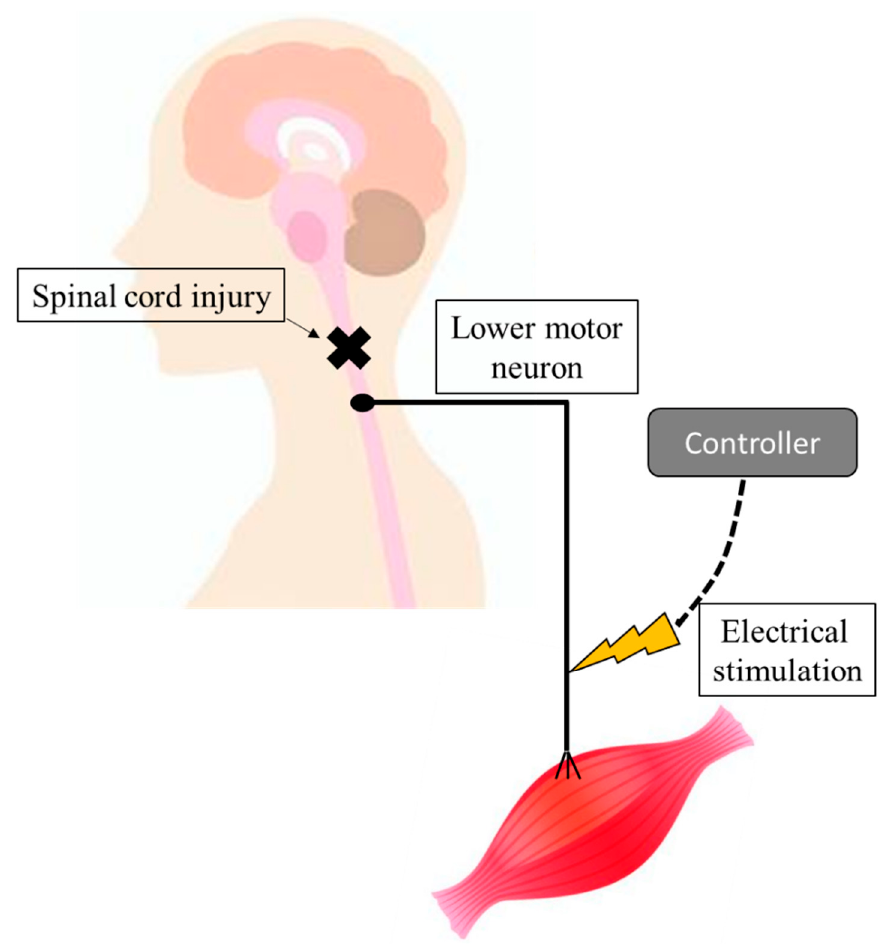
Figure 1. Schematic diagram of the principle of functional electrical stimulation (FES). Instead of upper motor neuron damaged by spinal cord injury, muscles contract and reconstruct function through lower motor neurons that are not damaged by controlled electrical stimulation.